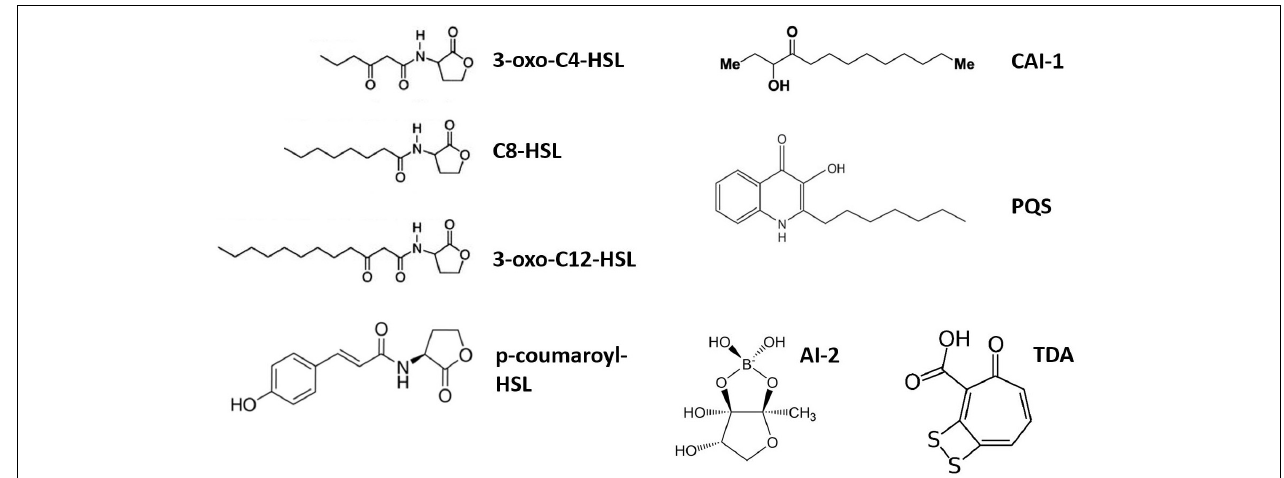
FIGURE 1 | Diversity of AI molecules produced by marine bacteria. Only three AHL (3-oxo- C4-, C8-, and 3-oxo-C12-HSL) structures are illustrated. 3-oxo-C4-HSL, N -3-oxo-butyryl- L -homoserine lactone; C8-HSL, N -octanoyl- L -homoserine lactone; 3-oxo-C12-HSL, N -3-oxo-dodecanoyl- L -homoserine lactone; p -coumaroyl-HSL, N -( p -coumaroyl)- L -homoserine lactone; CAI-1, cholera autoinducer-1 [(S)-3-hydroxytridecan-4-one]; PQS, Pseudomonas quinolone signal (2-heptyl-3-hydroxy-4-quinolone); AI-2, furanosyl-borate diester; TDA, tropodithietic